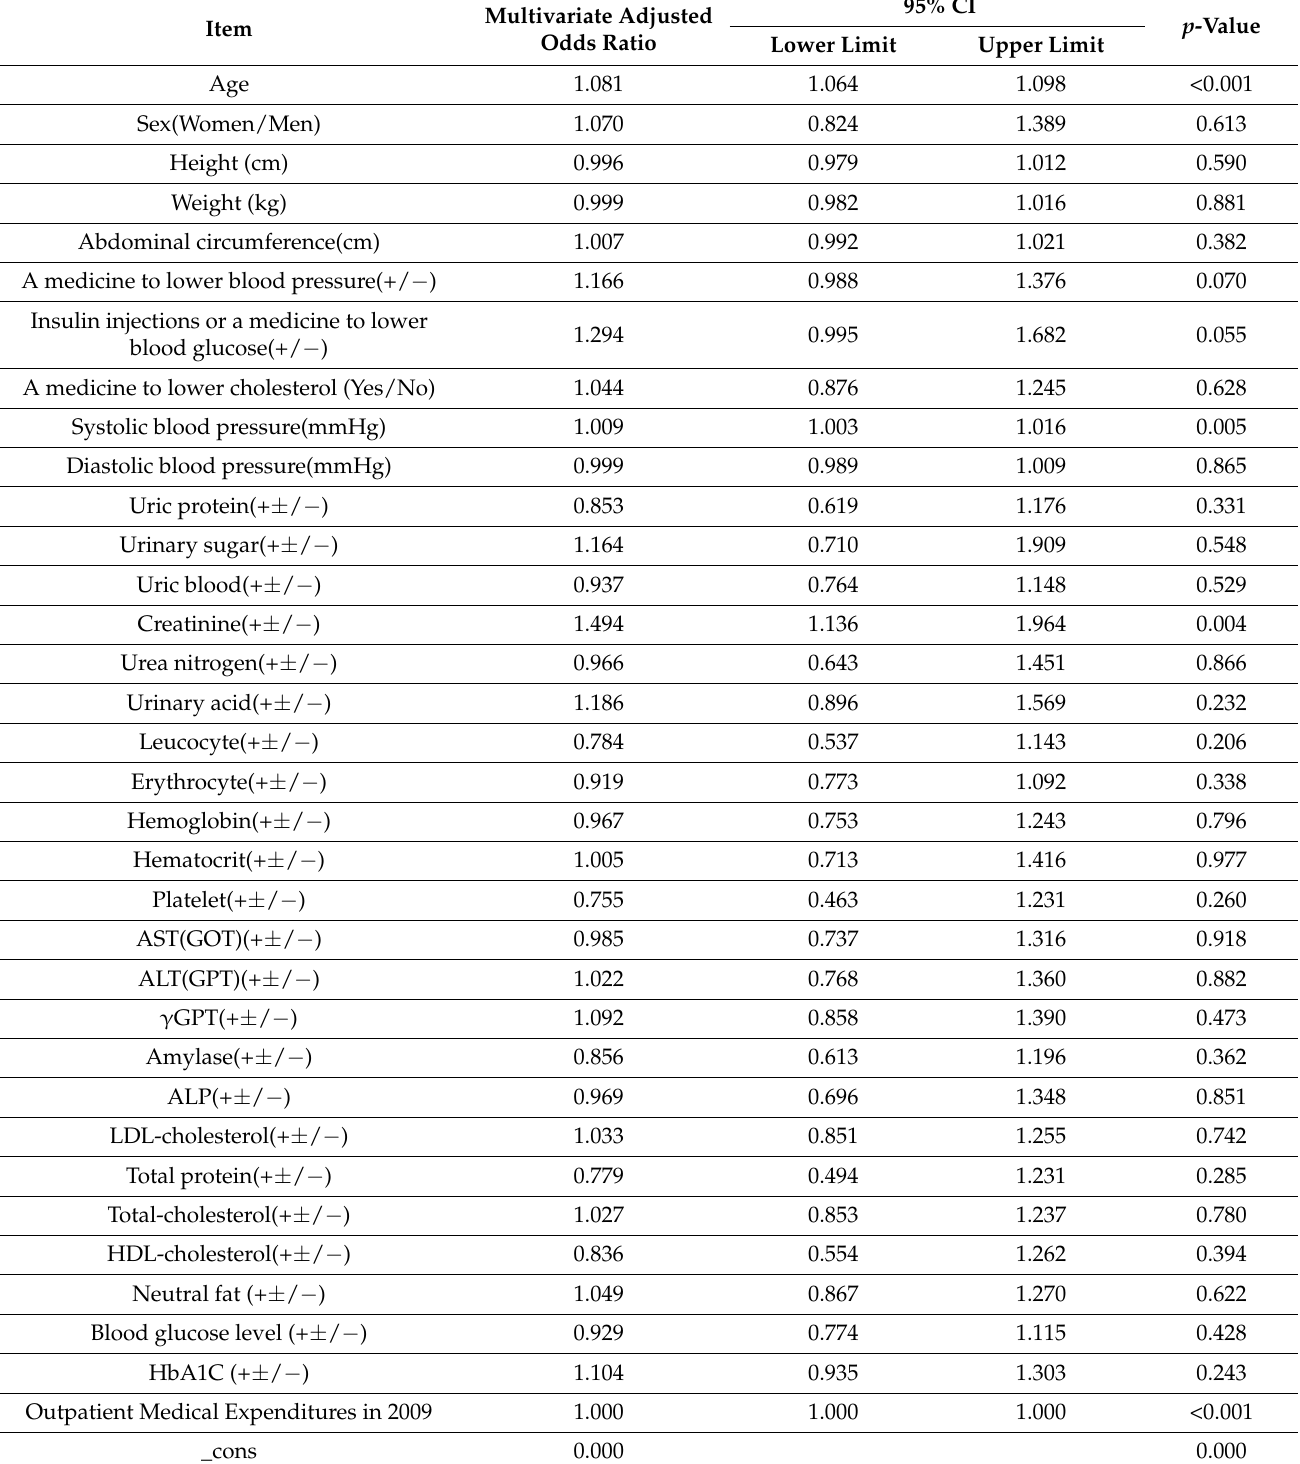
Table 3. Multivariate logistic regression analysis of biochemical tests in